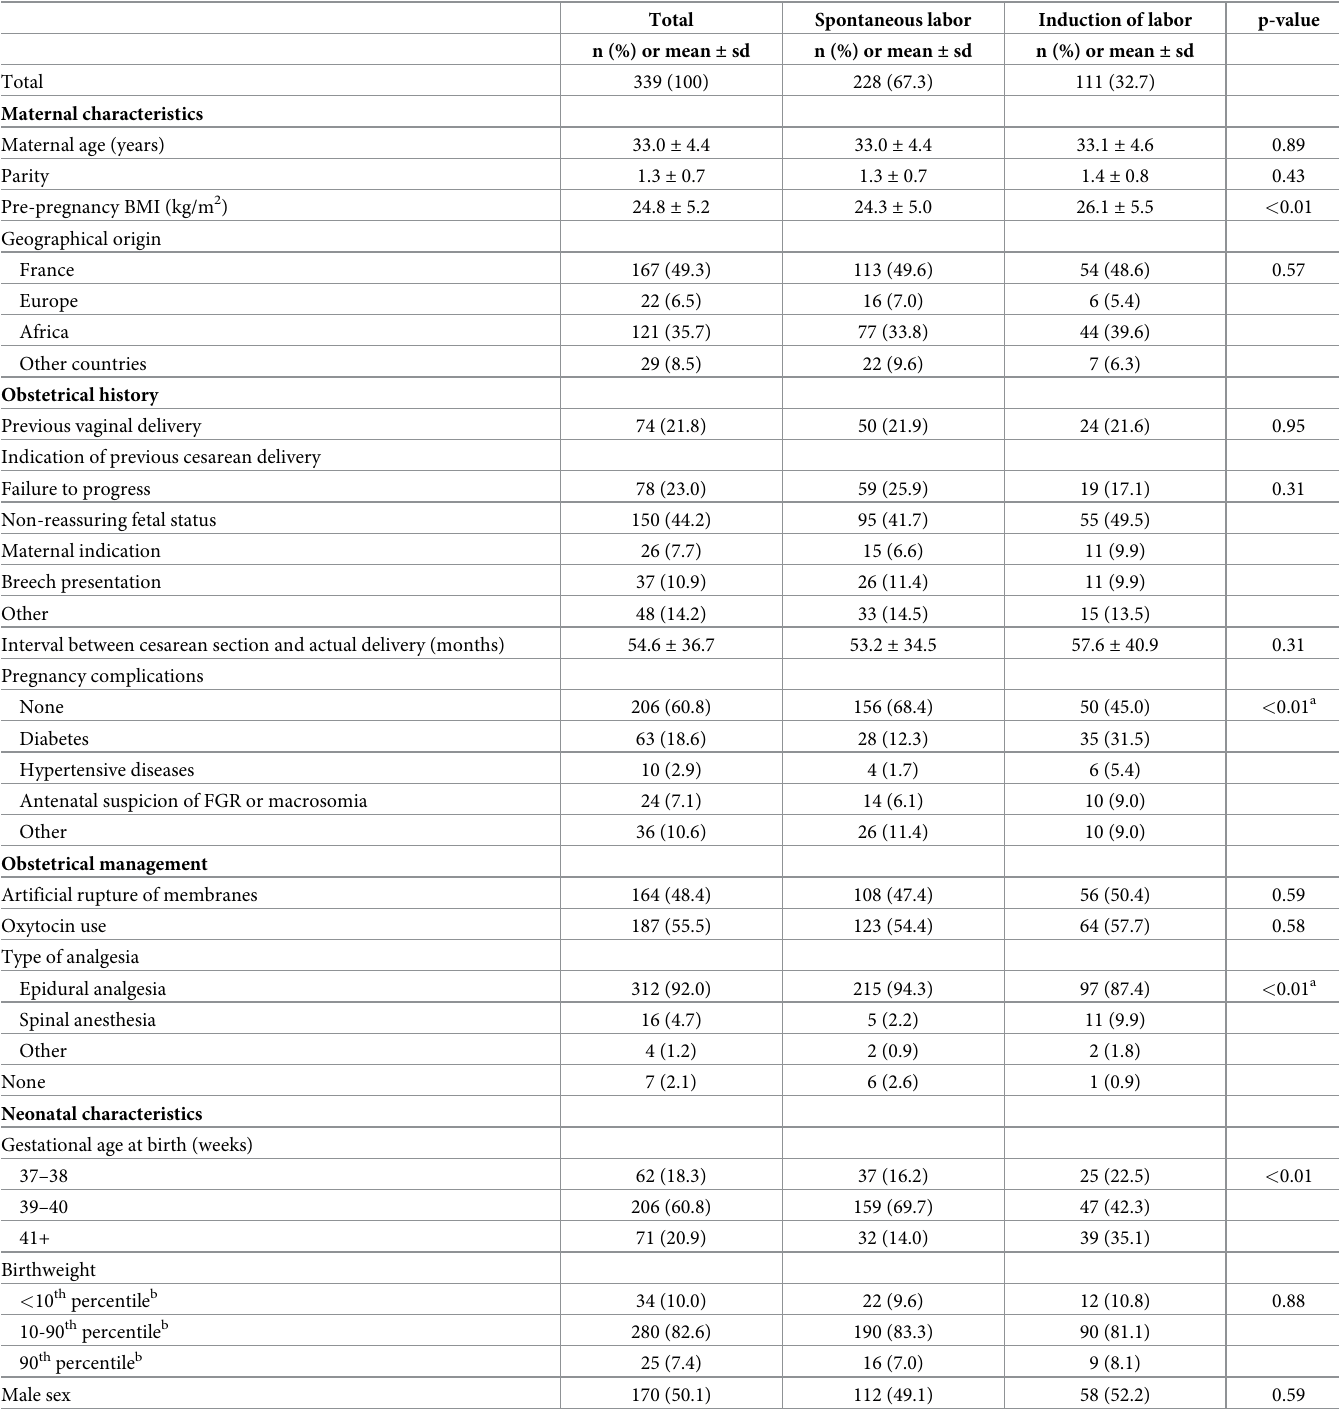
Table 1. Maternal, obstetrical and neonatal characteristics according to mode of onset of